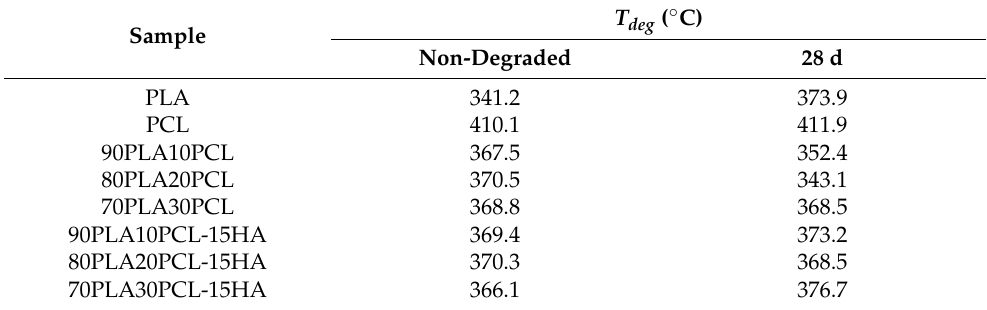
Figure 8. Second heating scan from DSC measurements before and after 28 days of degradation on pure PLA and PCL ( A ), 90PLA10PCL and 70PLA30PCL blends ( B ) and 90PLA10PCL-15HA and 70PLA30PCL-15HA composite blends ( C ). Table 5. Degradation temperature for the different materials before and after degradation for 28